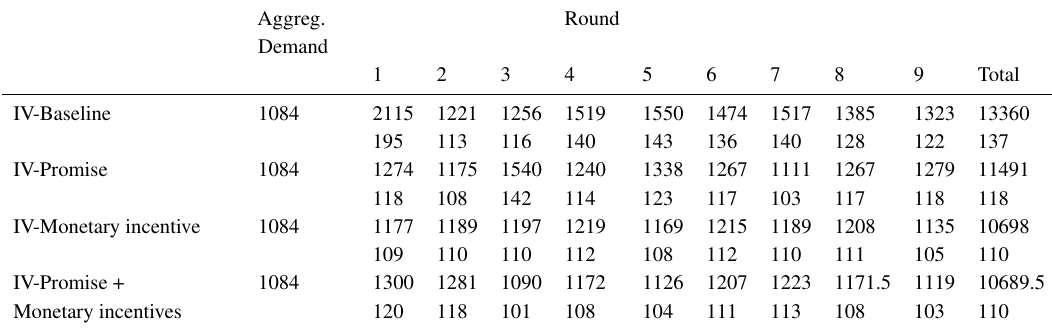
Table 3: Aggregate bidding behavior by treatment and round